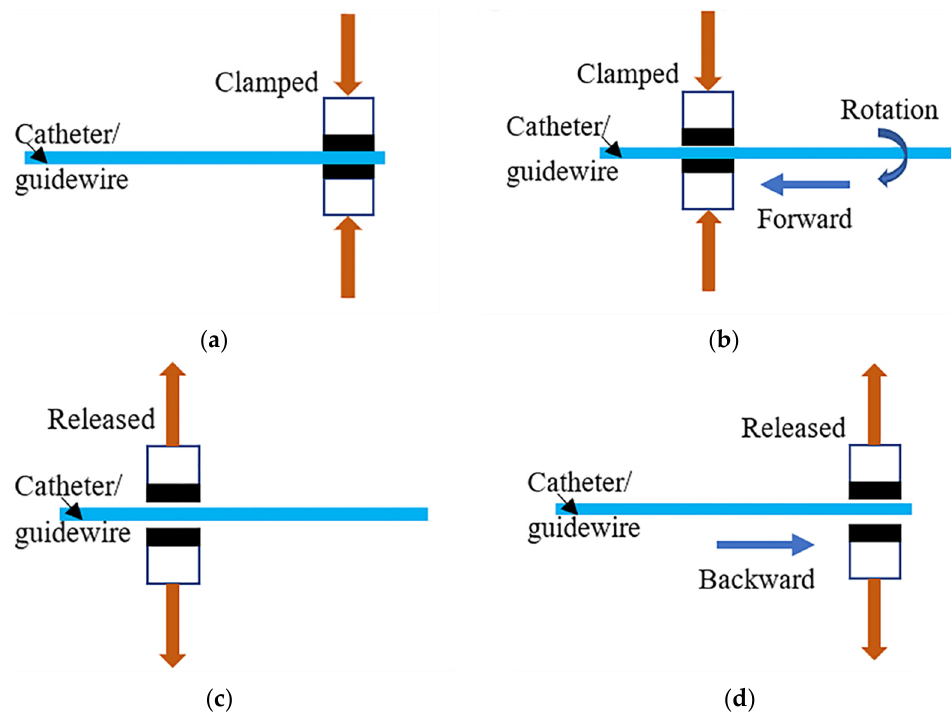
Figure 9. A schematic diagram of the reciprocating manipulation. ( a ) At the initial point position, the grasper clamps the catheter/guidewire; ( b ) it clamps the catheter/guidewire for forward or rotational movement; ( c ) after reaching the platform endpoint, it releases the catheter/guidewire; ( d ) the grasper returns to the initial position.